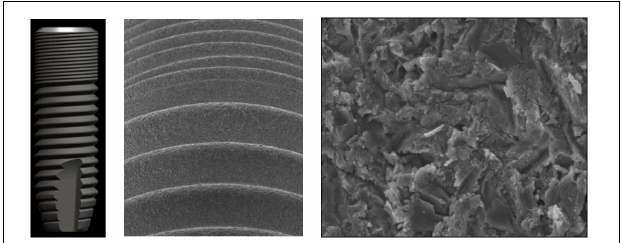
FIGURE 3 | Surface features and scanning electron micrographs of a OsseoSpeed dental implant